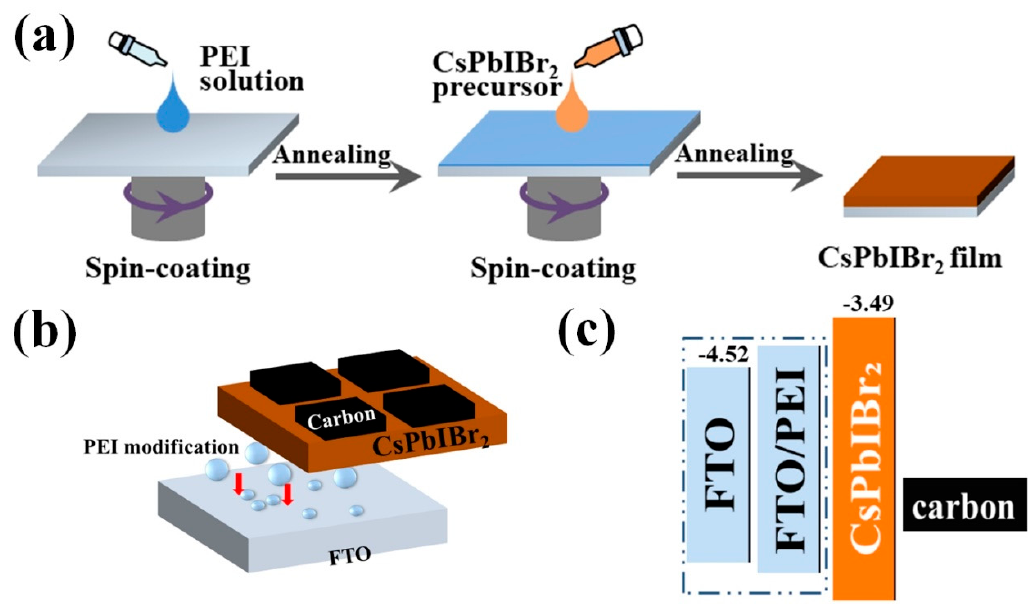
Figure 1. ( a ) Fabrication processes of the devices. ( b ) Schematic structure of perovskite solar cells (PSCs) without / with the polyethyleneimine (PEI) modification. ( c ) Schematic energy levels of the corresponding layers in PSCs.